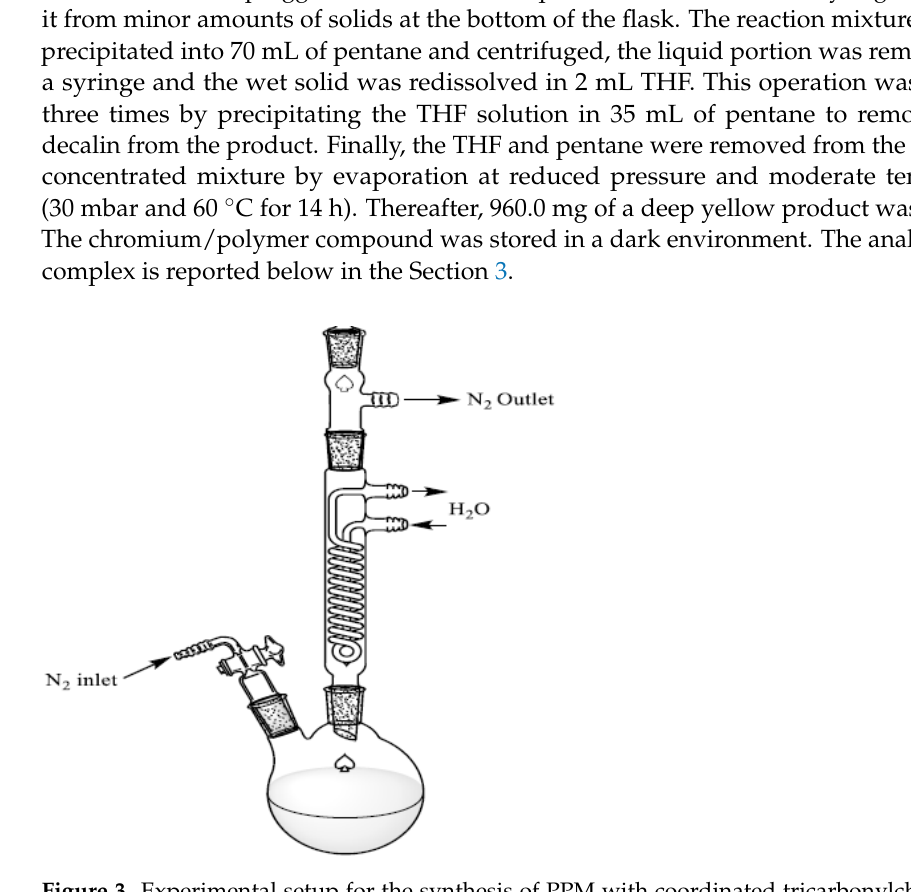
Figure 3. Experimental setup for the synthesis of PPM with coordinated tricarbonylchromium(0) entities.